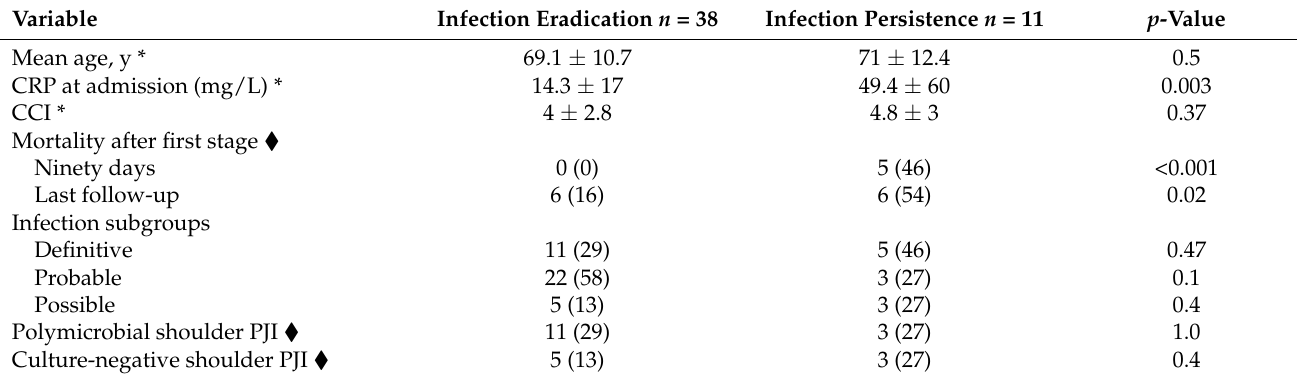
Table 2. Demographic data, clinical, and laboratory findings of the groups with infection eradication and infection persistence.